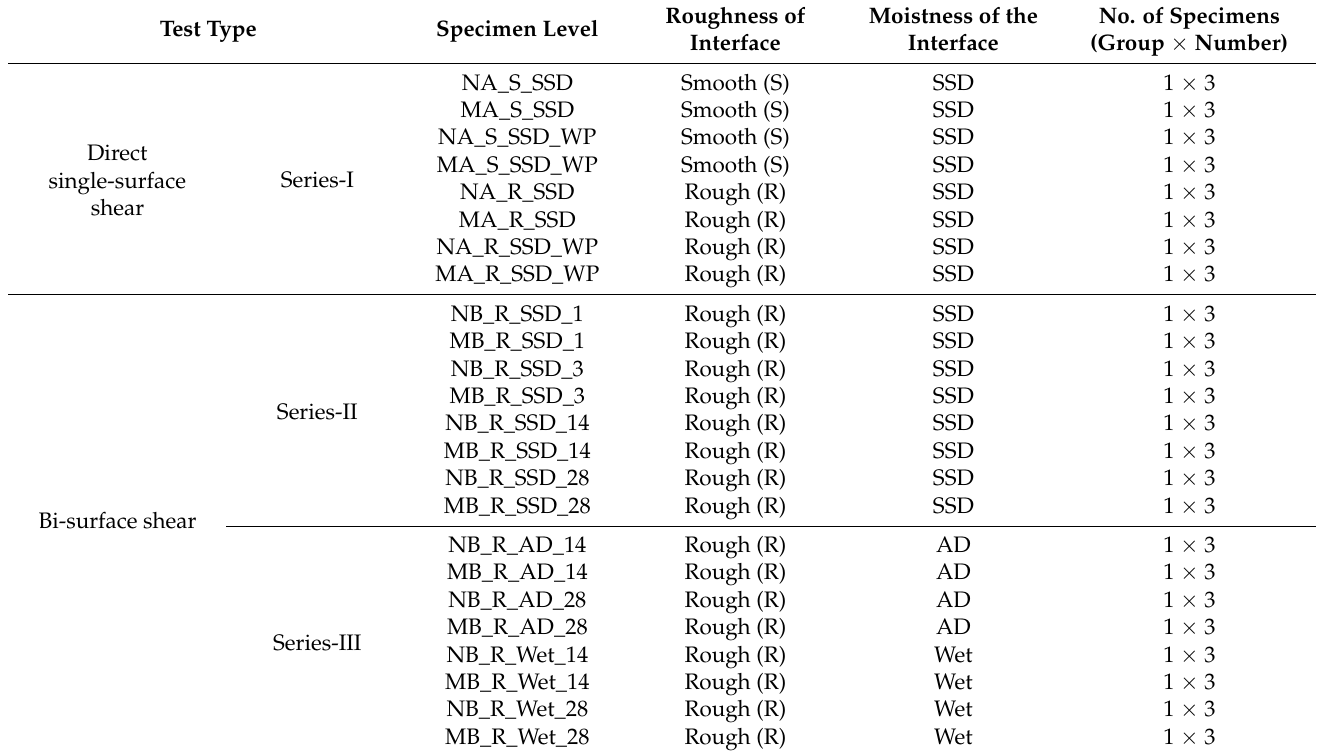
Table 4. Numbers of composite specimens for the interfacial shear